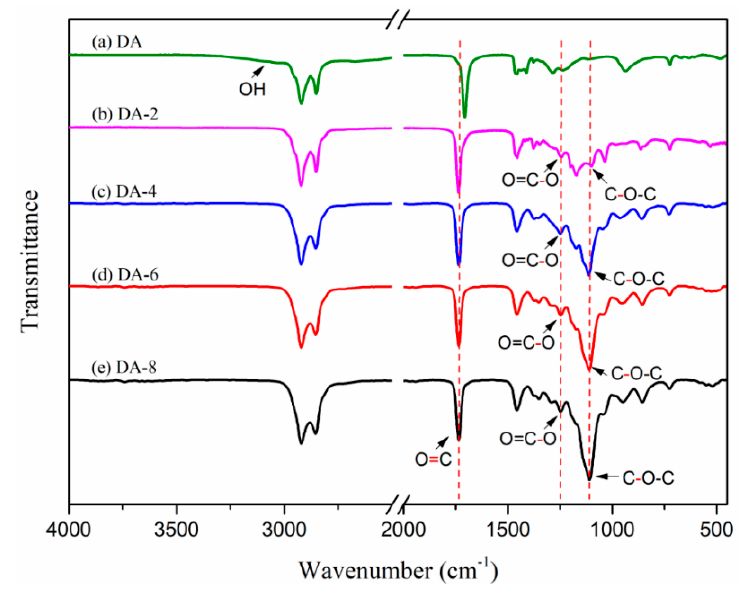
Figure 2. FT-IR spectra of DA and DA-2n.